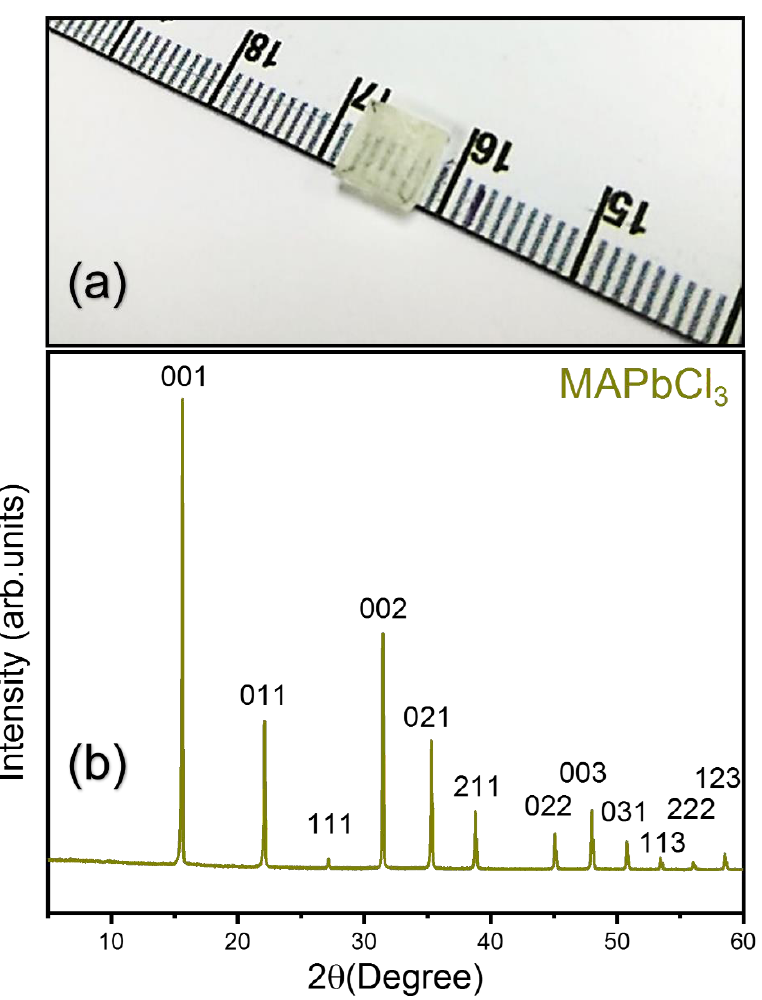
Figure 1. (Color online) ( a ) A picture of the grown single crystal. ( b ) The X-ray diffraction pattern of the powder MAPbCl 3 .